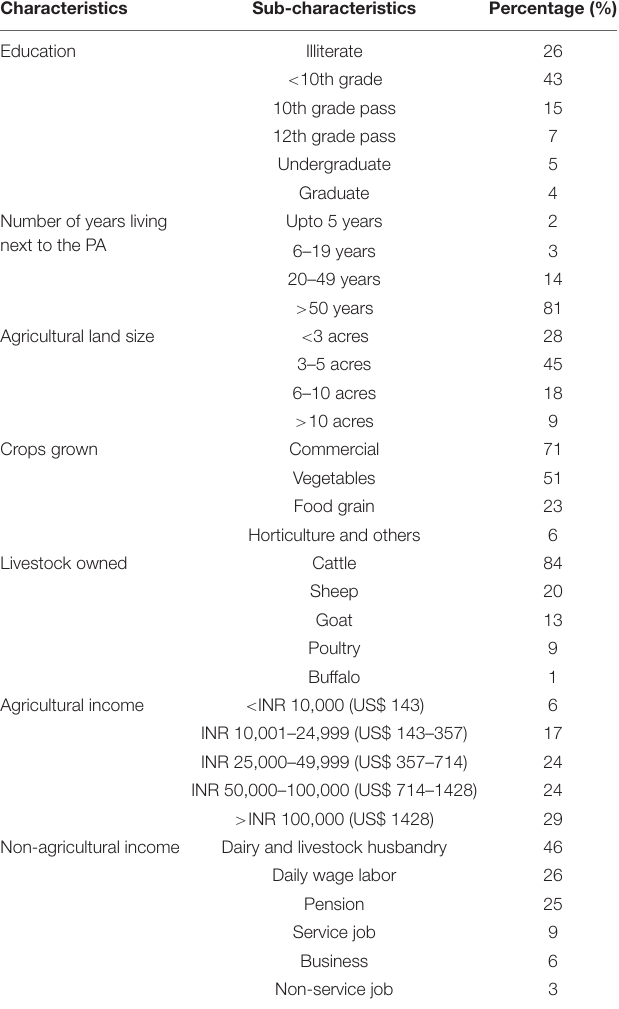
TABLE 2 | Landowner